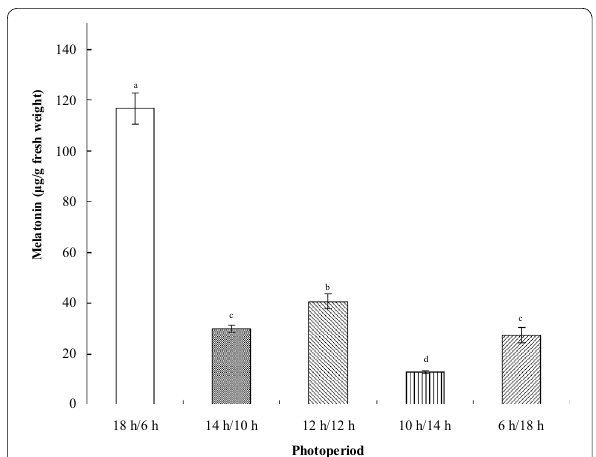
Fig. 4 Melatonin concentrations of H. perforatum L. leaves harvested at ZT6 for extraction for various photoperiods. Data are the mean of three replicates, and different letters represent significant differences at p <